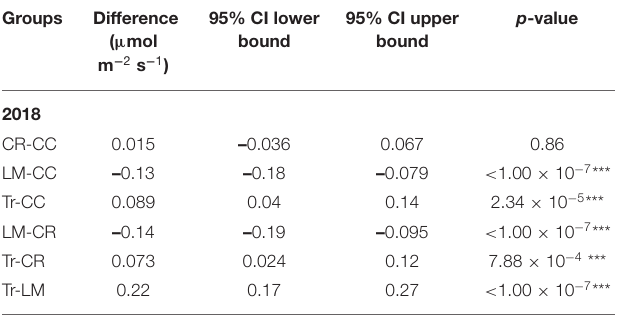
TABLE 3 | Average and standard deviation of trace gas fluxes (CO 2 : µ mol m − 2 s − 1 , N 2 O and CH 4 : µ mol m − 2 hr − 1 ) for four systems throughout the whole